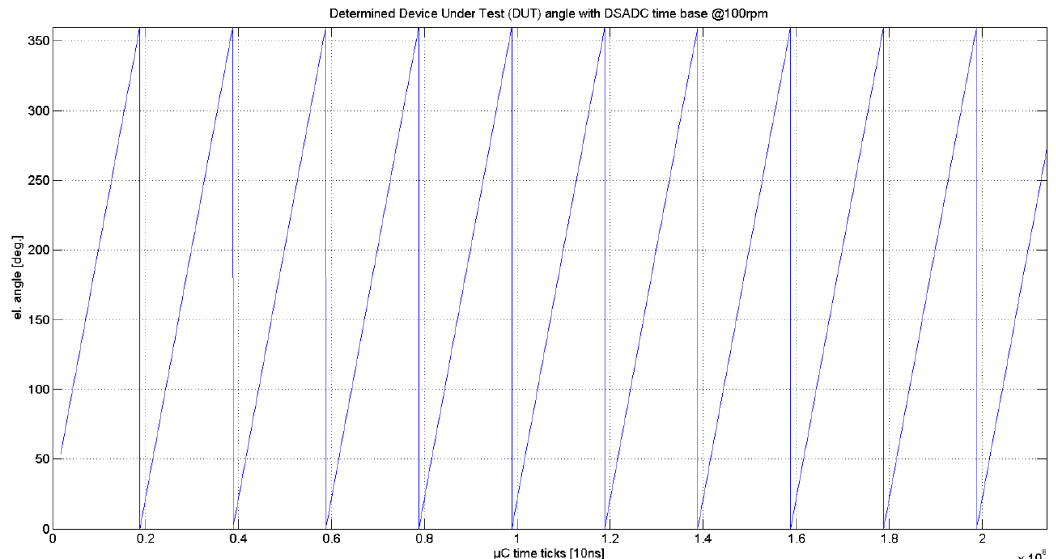
Figure 19. Determined DUT resolver angle based on the normalized, symmetric sine and cosine signals (Figure 18) represented in the μ C time base (10 ns).